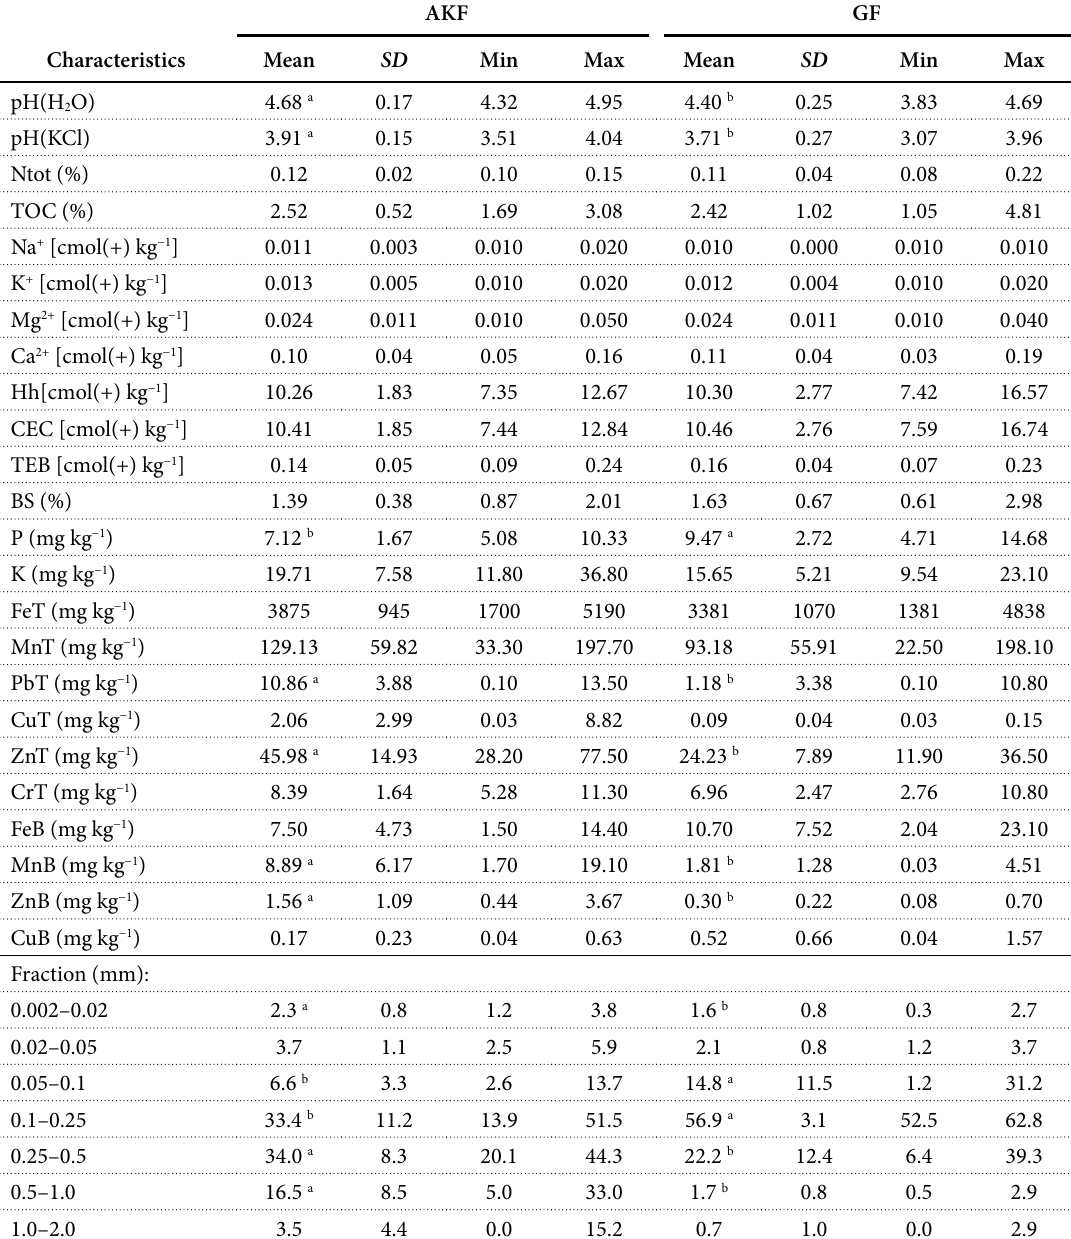
Tab. 3 Physicochemical properties of soils of Arnica montana habitats.